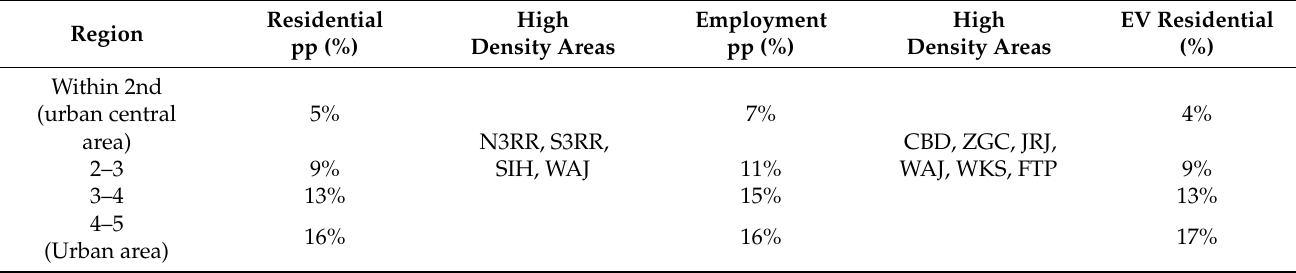
Table 2. Descriptive statistics of the job-housing proportion of the ring roads.